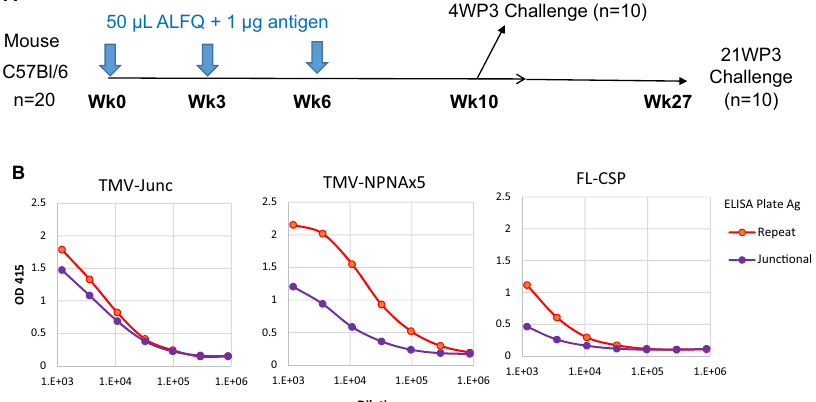
Fig. 2 Study 1 design and immunogenicity for TMV-Junc , TMV-NPNAx5, FL-CSP. A Outline of study design. B ELISA curves (mean of two experiments) showing reactivity to repeat (NANPx6) and Junctional peptide